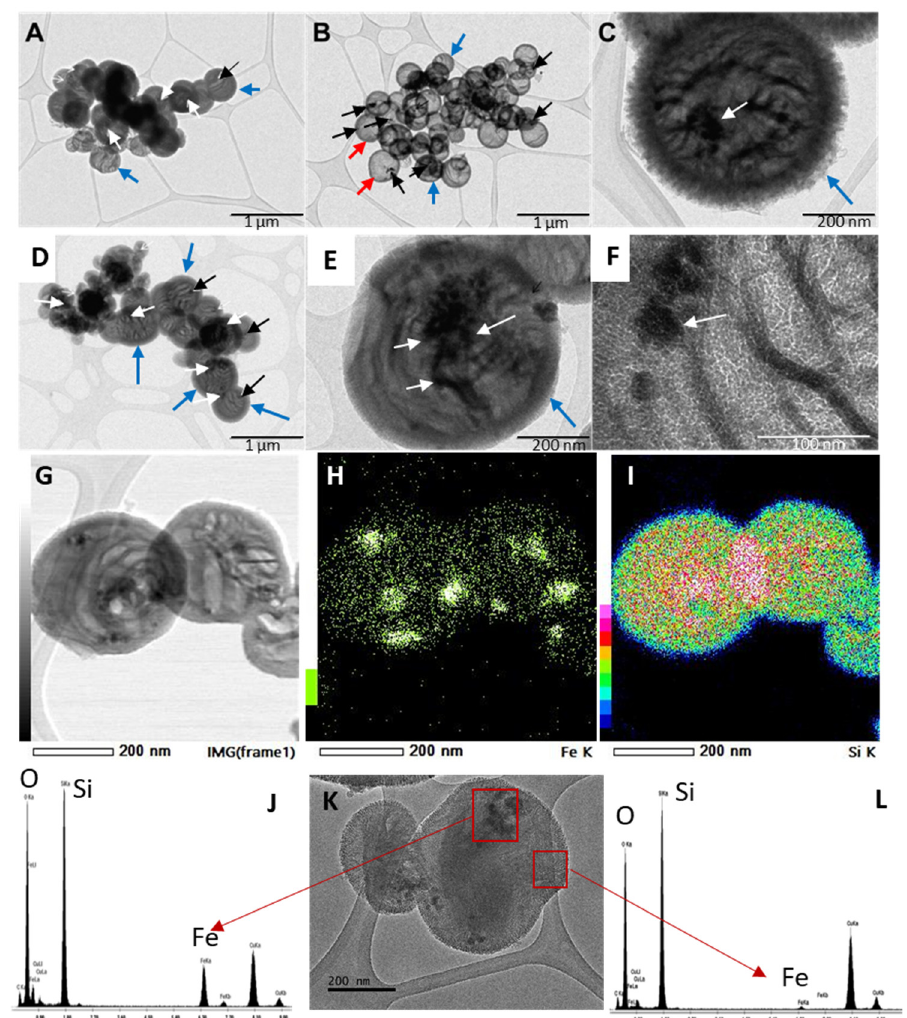
Figure 4. TEM images of the Fe 3 O 4 @MSN10-c ( A – C ) and Fe 3 O 4 @MSN10-b ( D – F ) samples. The black and white arrows correspond to magnetite nanoparticles. STEM image and elemental mapping of Fe and Si of the Fe 3 O 4 @MSN10-b ( G – I ). Elemental analysis in areas corresponding to small particles with dark contrast ( J – K ) and areas with no small particles and clear contrast ( K – L ).